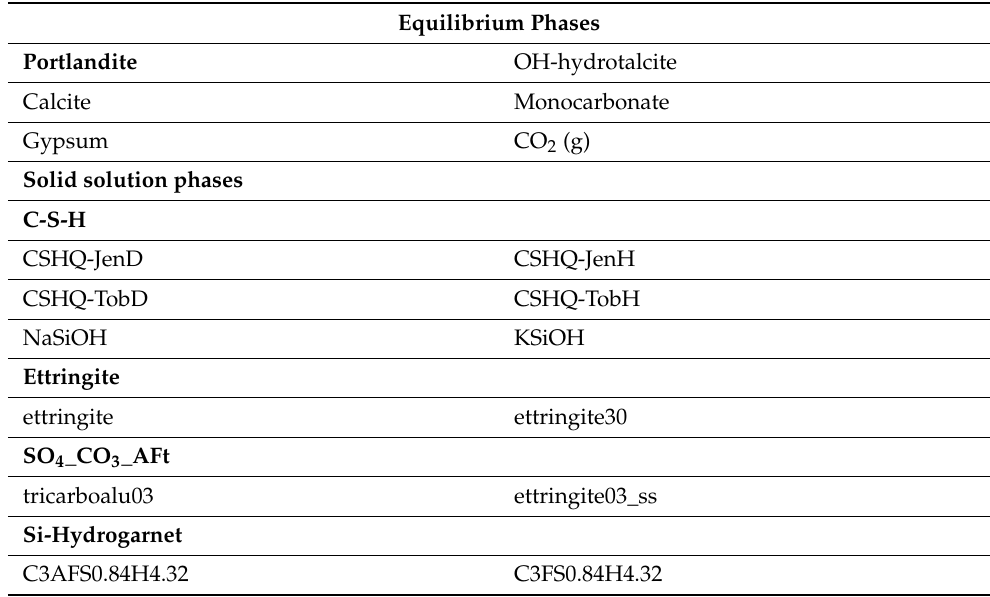
Table A2. Thermodynamic database for the chemical equilibrium model, from [16].